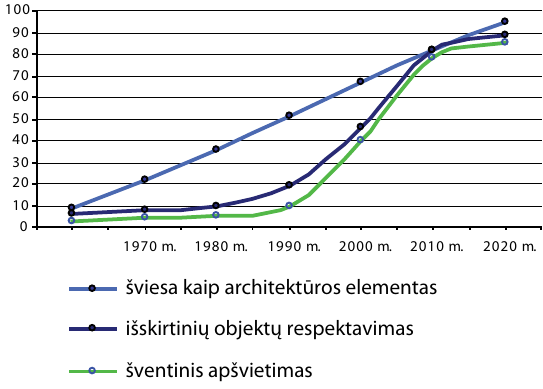
Plintant naujoms technologijoms miestui